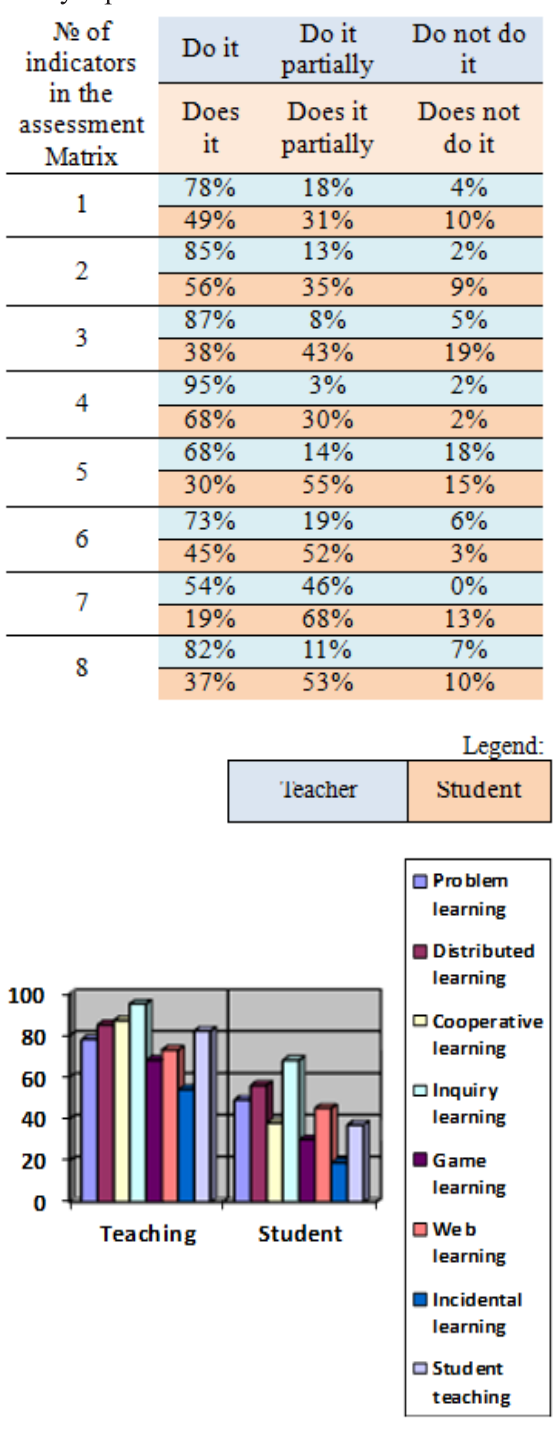
Table 4. Results. Factor 1 „Reproduc -